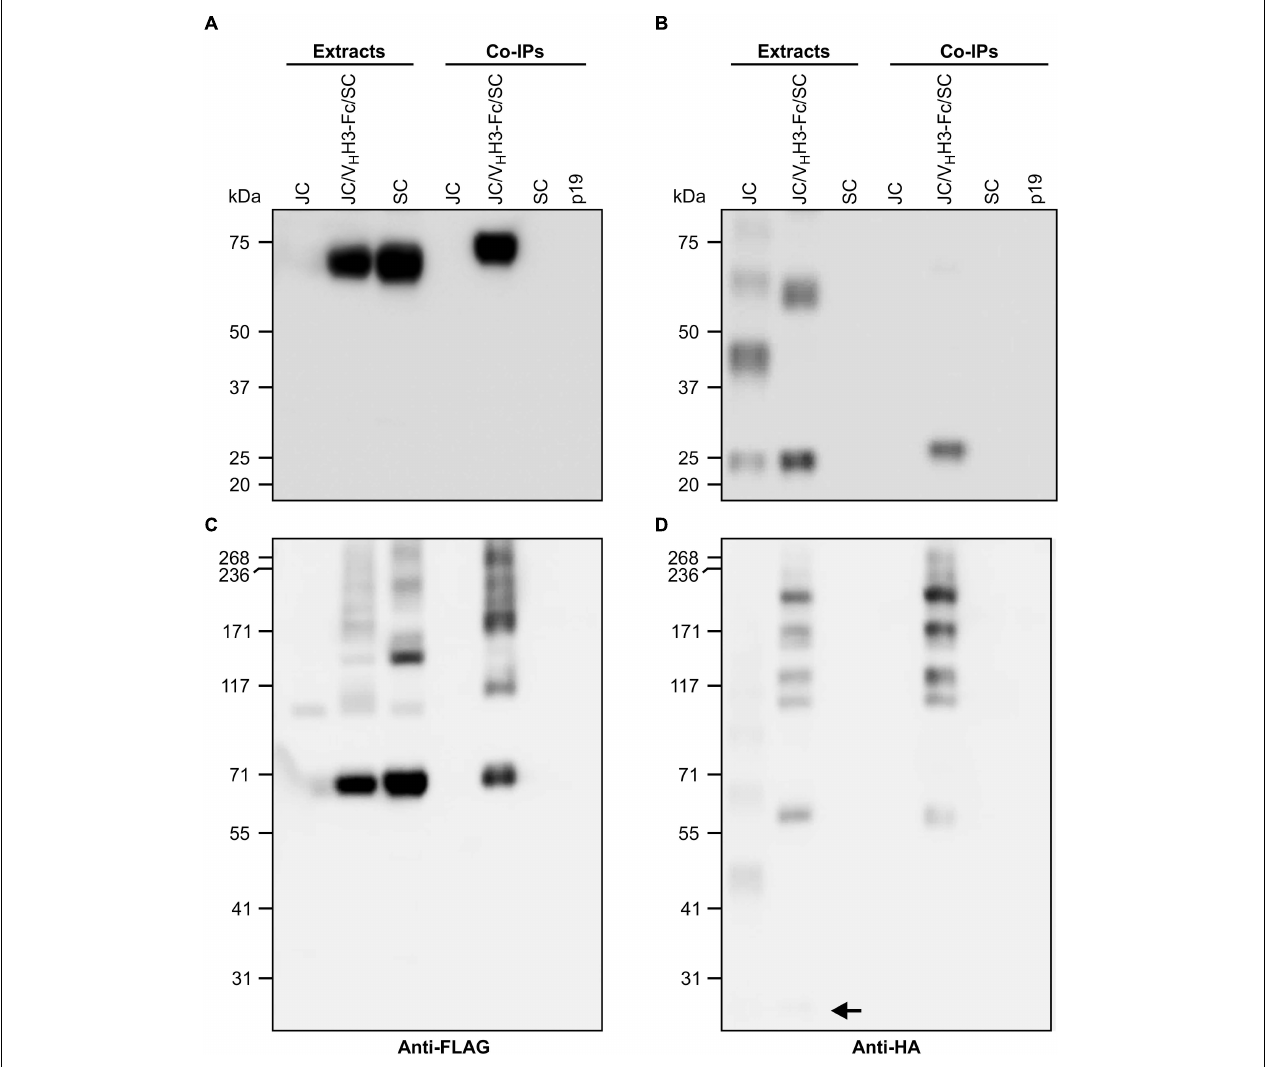
FIGURE 3 | V H H3-sIgA subunits physically associate with one another. N. benthamiana leaf tissue co-infiltrated with all V H H3-sIgA subunits was collected at 6 dpi, and recombinant proteins were immunoprecipitated with an anti-c-Myc antibody. (A,B) Both cell extracts and immunoprecipitates were resolved by SDS-PAGE under reducing conditions. (C,D) SDS-PAGE performed under non-reducing conditions. (A,C) Immunoblots were detected with anti-FLAG antibodies. (B,D) Immunoblots were detected with anti-HA antibodies. Arrow points to a faint but nonetheless present monomeric JC band. TSP from p19-infiltrated N. benthamiana leaves was used as negative